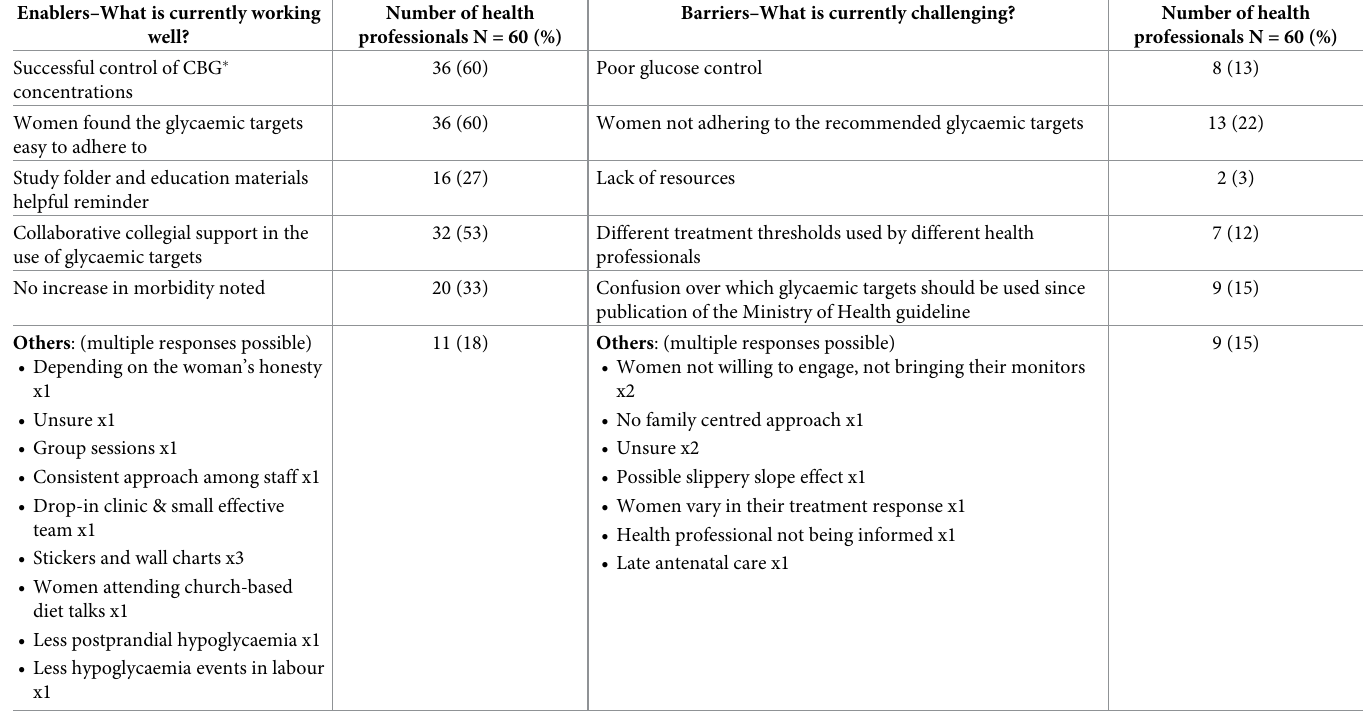
having church-based diet talks and a consistent approach among staff (Table 2). Three (5%) Key Informant Health Professionals commented that glycaemic target reminder stickers and wall charts were helpful reminders for recommending the current less tight glycaemic treat- ment targets for women with GDM (Table 2). Table 2. Barriers and enablers with use of less tight glycaemic treatment targets amongst Key Informant Health Professionals providing care for women with GDM # . Enablers–What is currently working